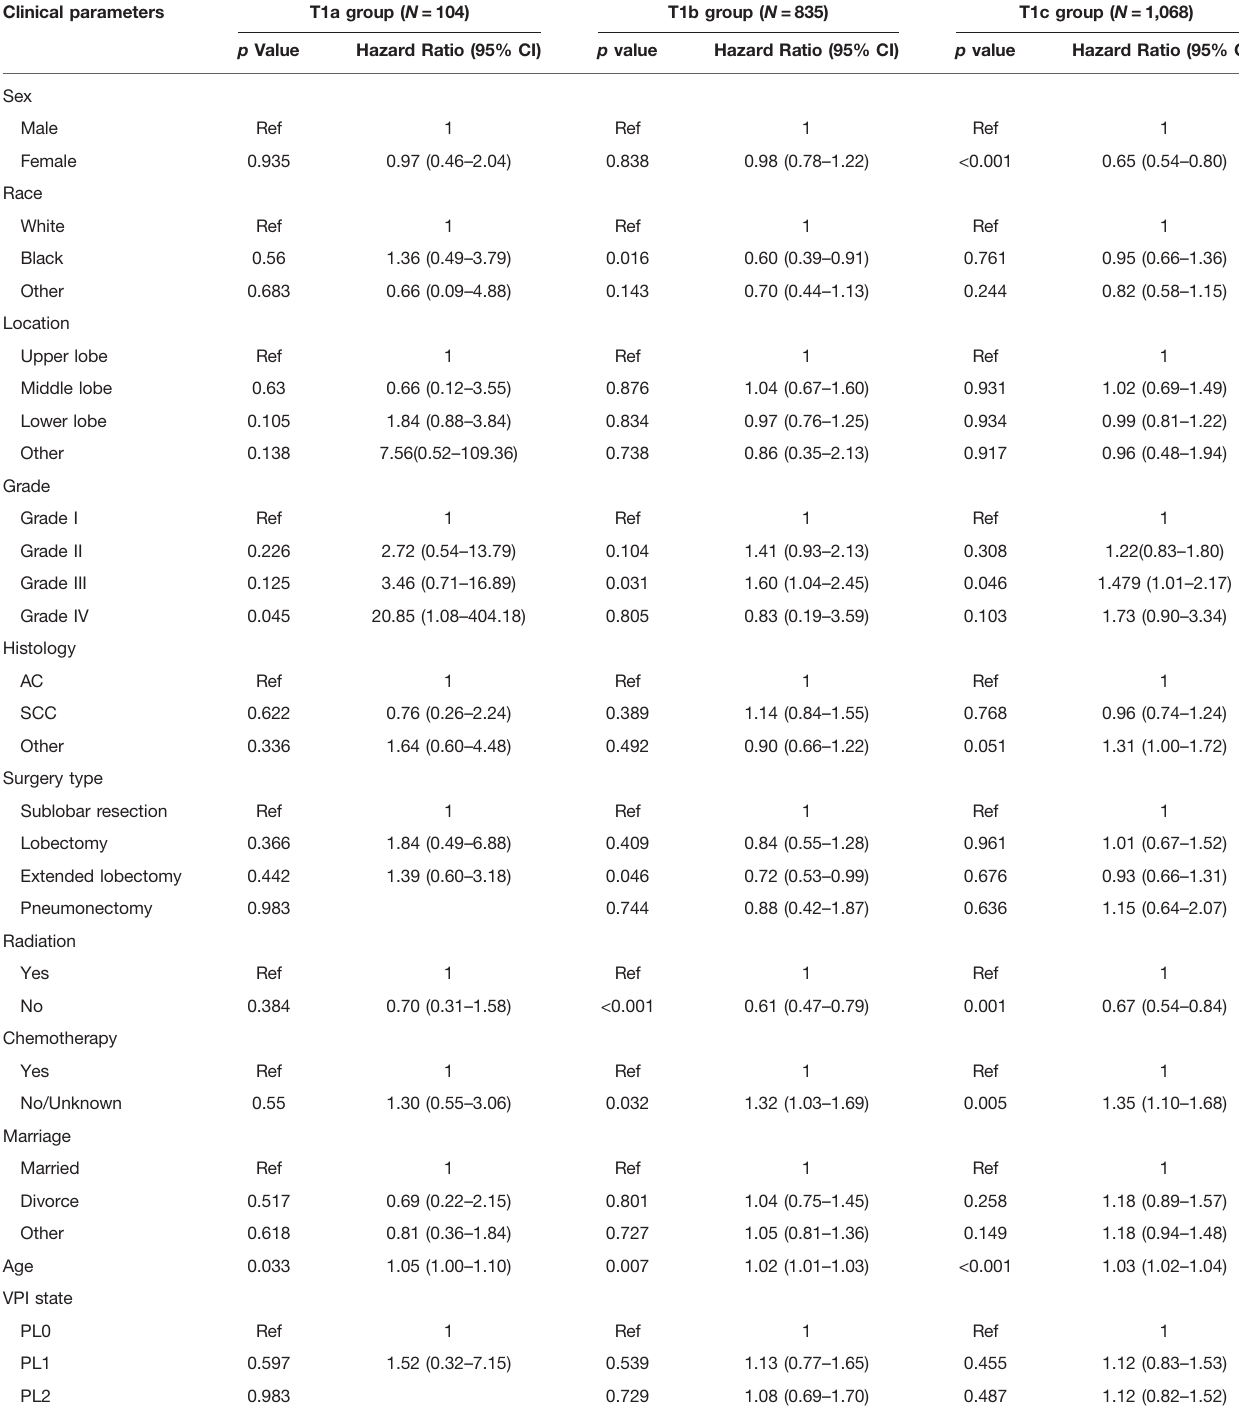
TABLE 4 | Multivariate COX regression of the prognostic factors of LCSS in patients with LN metastasis ( N =2,007). Clinical